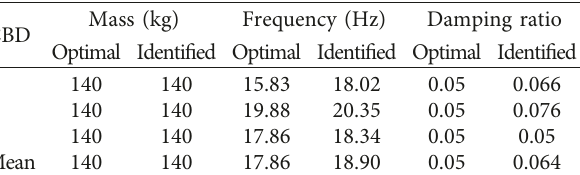
Figure 8: Free vibration attenuation curve for CBD1–3. Table 2: Parameters of the three coal bucket